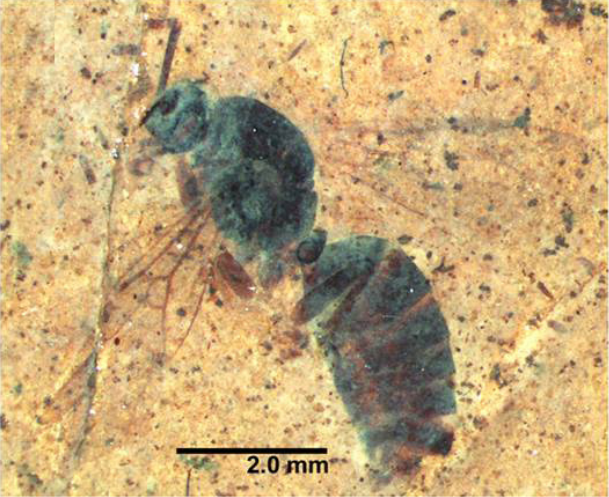
Fig 7 . Holotype male, Formica annosa (USNM#